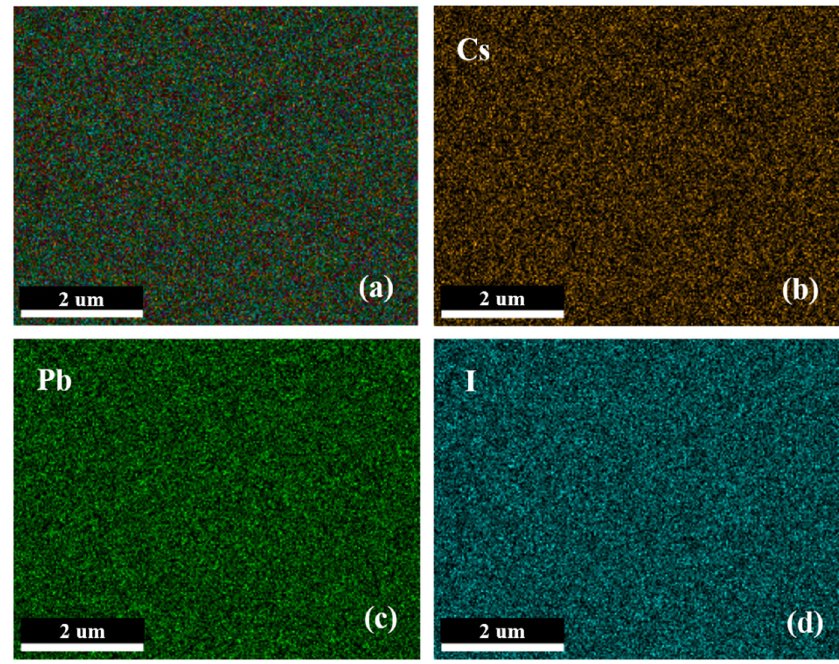
Figure 2. EDS elemental mapping images of ( a ) all elements; ( b ) Cs; ( c ) Pb; ( d ) I in the MAPbI 3 film doped with CsPbI 3 QDs